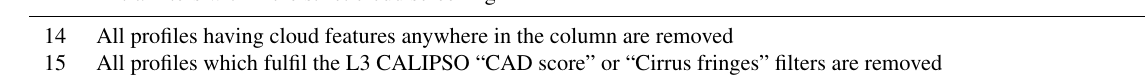
Table 1. Quality control procedures and filtering applied in CALIPSO data. 1 Screen out all features that are not aerosols 2 Set all clear air profile measurements to 0.0km − 1 3 Samples below opaque cloud and aerosol layers are removed 4 Clear-sky mode: only measurements in which no clouds are in the column are considered 5 Large negative near-surface extinction filter: all level 2 aerosol extinction samples adjacent to the surface having a value less than − 0.2km − 1 are ignored 6 Samples where aerosol extinction uncertainty is less than 99.9km − 1 are allowed 7 CAD score: only features having cloud–aerosol discrimination (CAD) scores between − 100 and − 20 are used 8 Only features having extinction QC flag values of 0, 1, 16 or 18 are allowed 9 Cirrus fringes: misclassified cirrus in the upper troposphere, coming from CAD artifacts, are removed 10 Remove measurements which are contaminated by surface values: extinction values near the surface less than − 0.2km − 1 are ignored 11 Undetected surface-attached aerosol low bias filter (changed between CALIPSO L3 version 1 and version 3): samples classified as “clear air” lying beneath the lowest quality screened aerosol layer whose base is below 250m from the local surface are ignored 12 Negative signal anomaly mitigation strategy: all level 2 aerosol extinction coefficients within 60m of the planetary surface are excluded from level 3 calculations (new in L3 version 3) 13 All non-dust aerosol types detected in the cell are assigned with a value of 0.0km − 1 Extra filters with more strict cloud screening 14 All profiles having cloud features anywhere in the column are removed 15 All profiles which fulfil the L3 CALIPSO “CAD score” or “Cirrus fringes” filters are